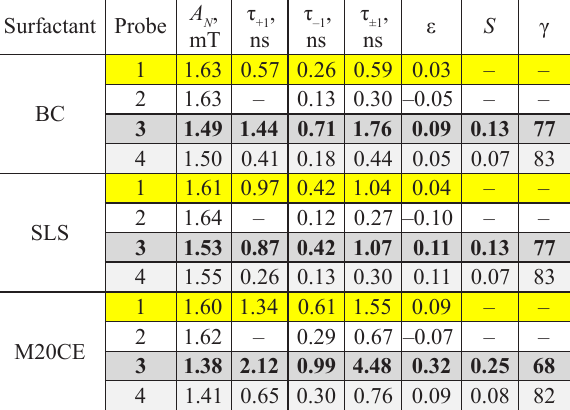
The difference in the rotational diffusion parame- ters of probe 2 and probe 1, whose nitroxyl radical is also localized in the polar part of the micelles, was due to Fig. 13. Rheograms of the aqueous solutions of P338 at their different molecular structures as well as the interac- 25 °С at concentrations: 1 – 10 %; 2 – 15 %; 3 – 17 %; tion of probe 1 cations with SLS anions or oxygen atoms 4 – 20 %; 5 – 25 % of the polar part of M20СЕ micelles.